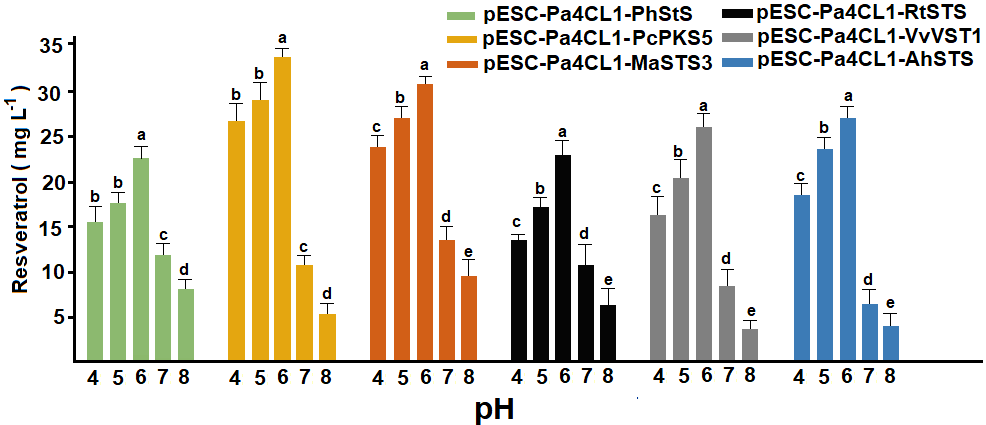
Figure 5. Effect of pH on the conversion of p -coumaric acid into resveratrol. Diverse letters indicate statistically significant differences ( p < 0.01). Error bars represent standard deviation of ten independent experiments (n = 10).